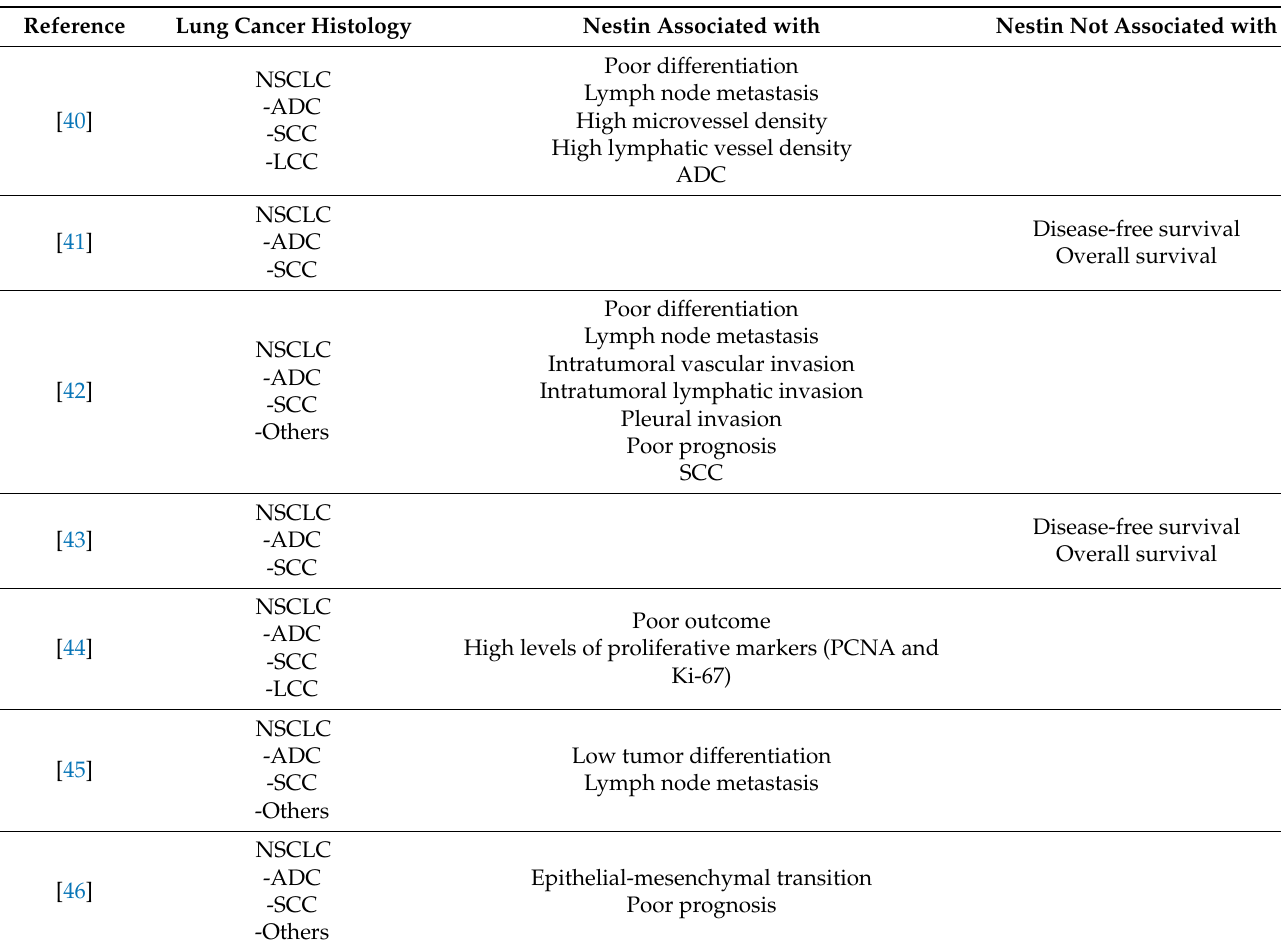
Table 1. Main clinical characteristics of lung cancer associated and not associated with the expression of nestin. Reference Lung Cancer